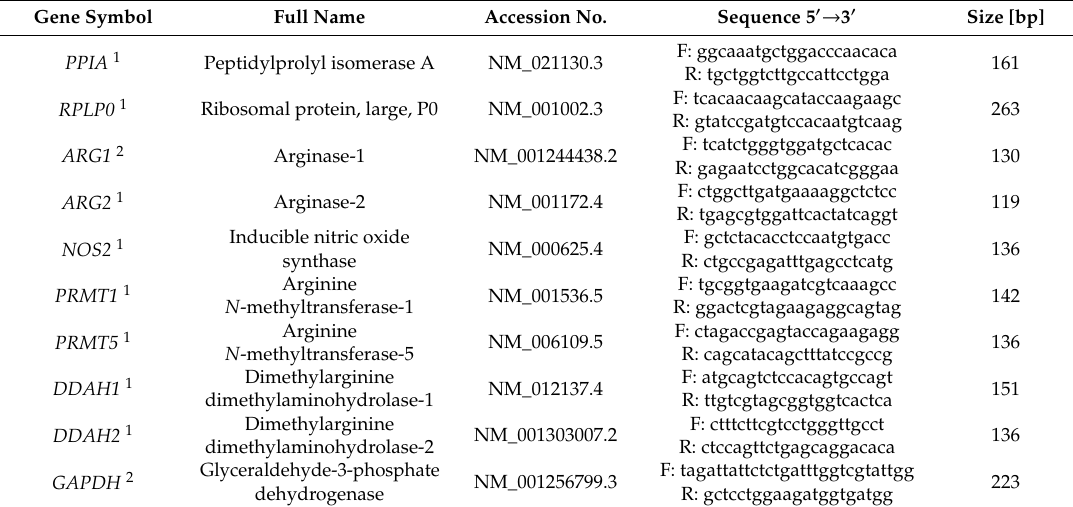
Table 4. Characteristics of applied